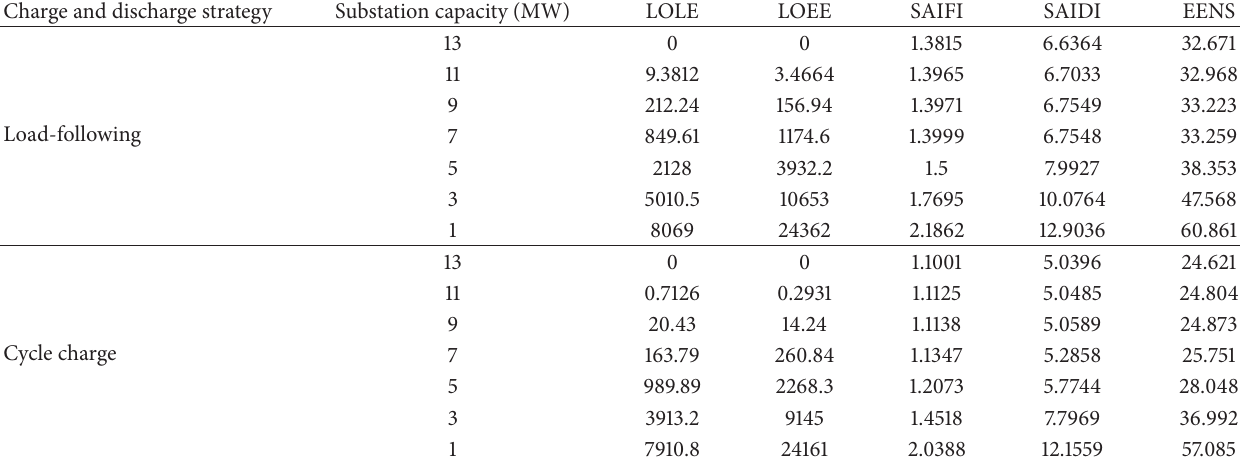
Table 1: Impacts of substation capacity.